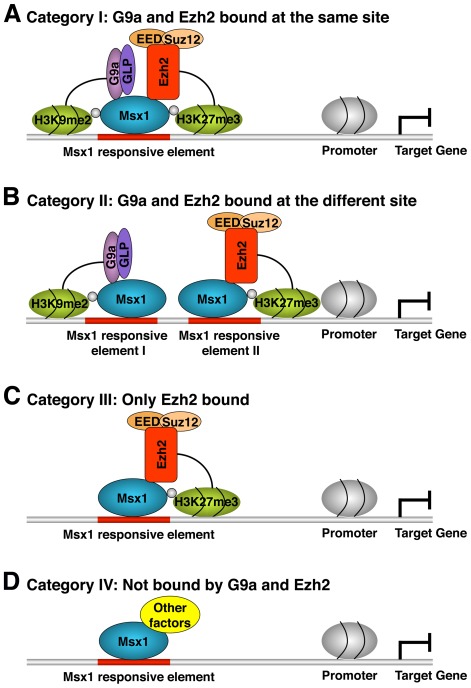
Working model.As described in the text, we have proposed that binding of the Msx1 homeoprotein to specific target genes brings G9a and/or Ezh2 to the regulatory regions of these genes to influence histone modifications. According G9a and Ezh2 bound status, the Msx1 bound and down-regulated target genes were categorized in 4 categories. (A) Category I, Msx1 brings G9a and Ezh2 to the same site on target genes. (B) Category II, Msx1 brings G9a and Ezh2 to the same target genes but at different sites. (C) Category III, Msx1 only brings Ezh2 to the Msx1 bound site on target genes. (D) Category IV, Msx1 do not brings ether G9a or Ezh2 to the target genes, but Msx1 may brings other factors to Msx1 bound site to repress target genes expression.